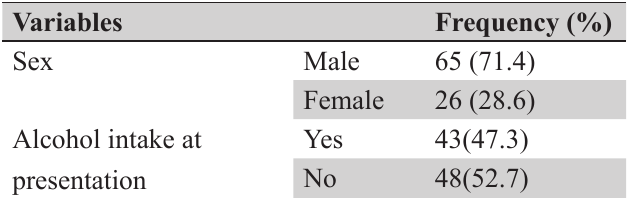
Table 1. Sociodemographic characteristics of the study population